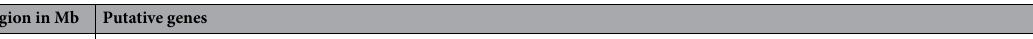
Breed Chr Genomic region in Mb Putative